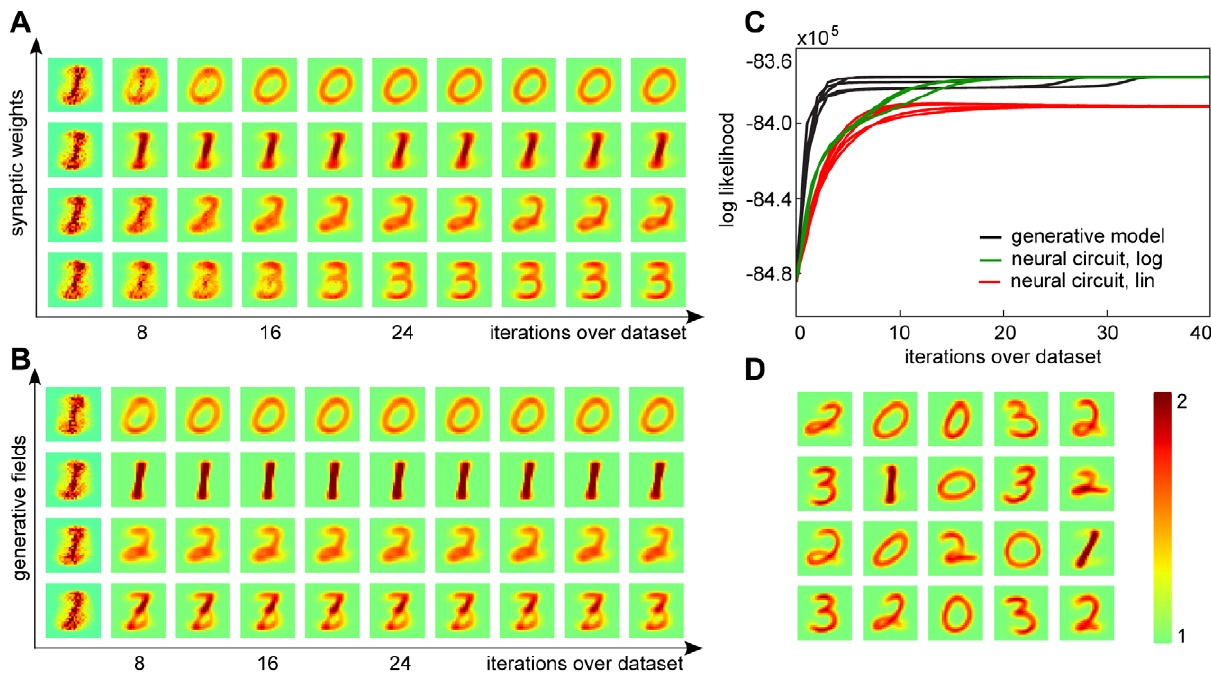
Figure 3. Learning on more realistic data. (A) Evolution of synaptic weights in the neural circuit on inputs from the MNIST database. (B) Evolution of generative fields using EM on the same data; for both input data consisted of 10000 data points from the digit classes 0 to 3 with normalization A ~ 900 . (C) Changes of the likelihood during learning for the neural circuit (both versions) and EM. (D) Synaptic weights learned by the circuit (linear version) on the same data but with five times more processing neurons.